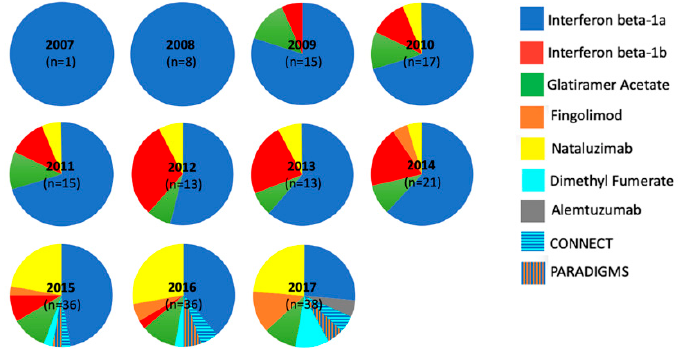
Figure 2. Disease-modifying treatments used in each year over the study period, demonstrating increasing variety over time. CONNECT (dimethyl fumarate vs. interferon beta-1a) and PARADIGMS (fingolimod vs. interferon beta-1a) denote clinical trials.